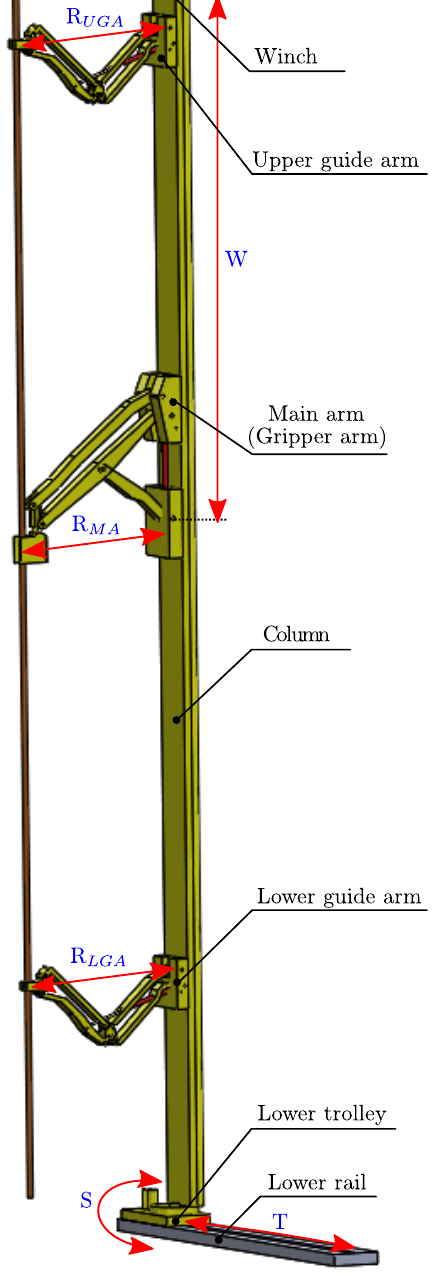
Figure 1: Considered offshore mechatronic system (simpli- fied CAD model of the multibody